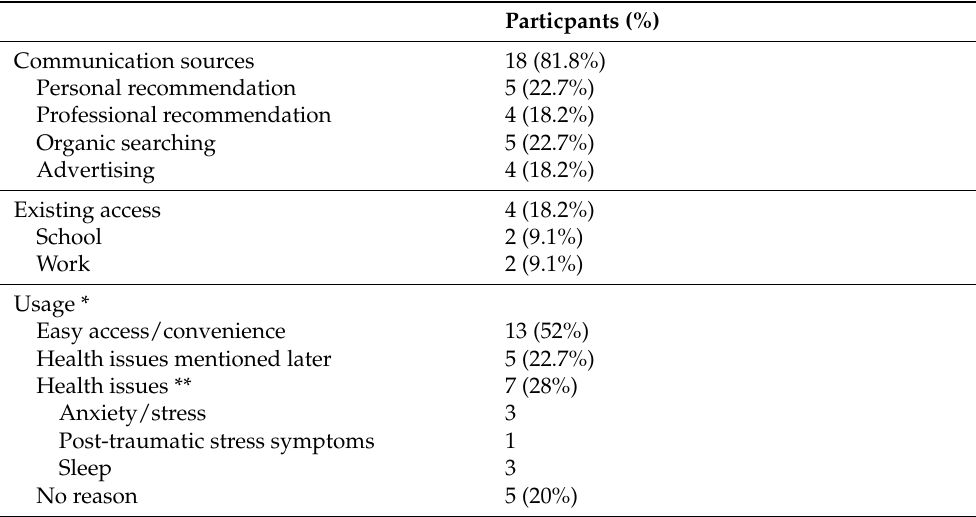
Table 2. Motivation and